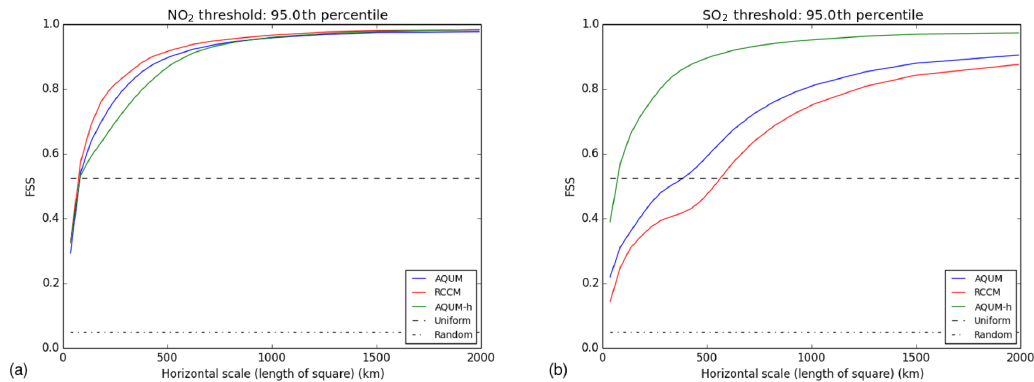
Figure 7. Fractional skill score for the 95th percentile for (a) NO 2 and (b) SO 2 . The RCCM is shown in red, AQUM in blue, and AQUM-h in green. The “Random” (dot-dashed) line represents the FSS for a random forecast with the same fraction of points over the domain exceeding the percentile threshold as the truth field. The “Uniform” (dashed) line represents a forecast with the same fraction of points above the percentile threshold in the neighbourhood surrounding each grid point as the truth field for every grid point. Above this line the forecast is considered